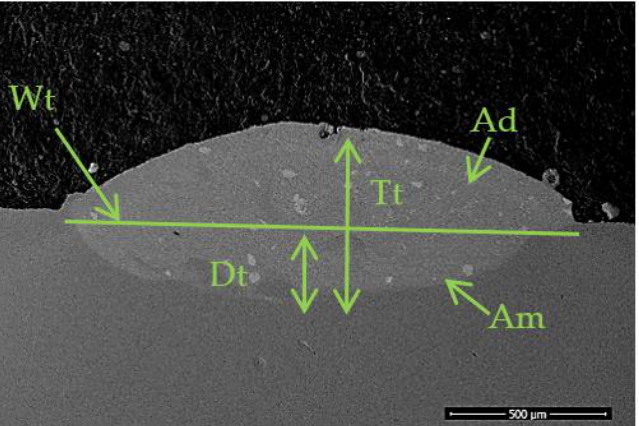
Figure 2. Back scattered electron micrograph of a laser cladded single track indicating the main geometrical dimensions.